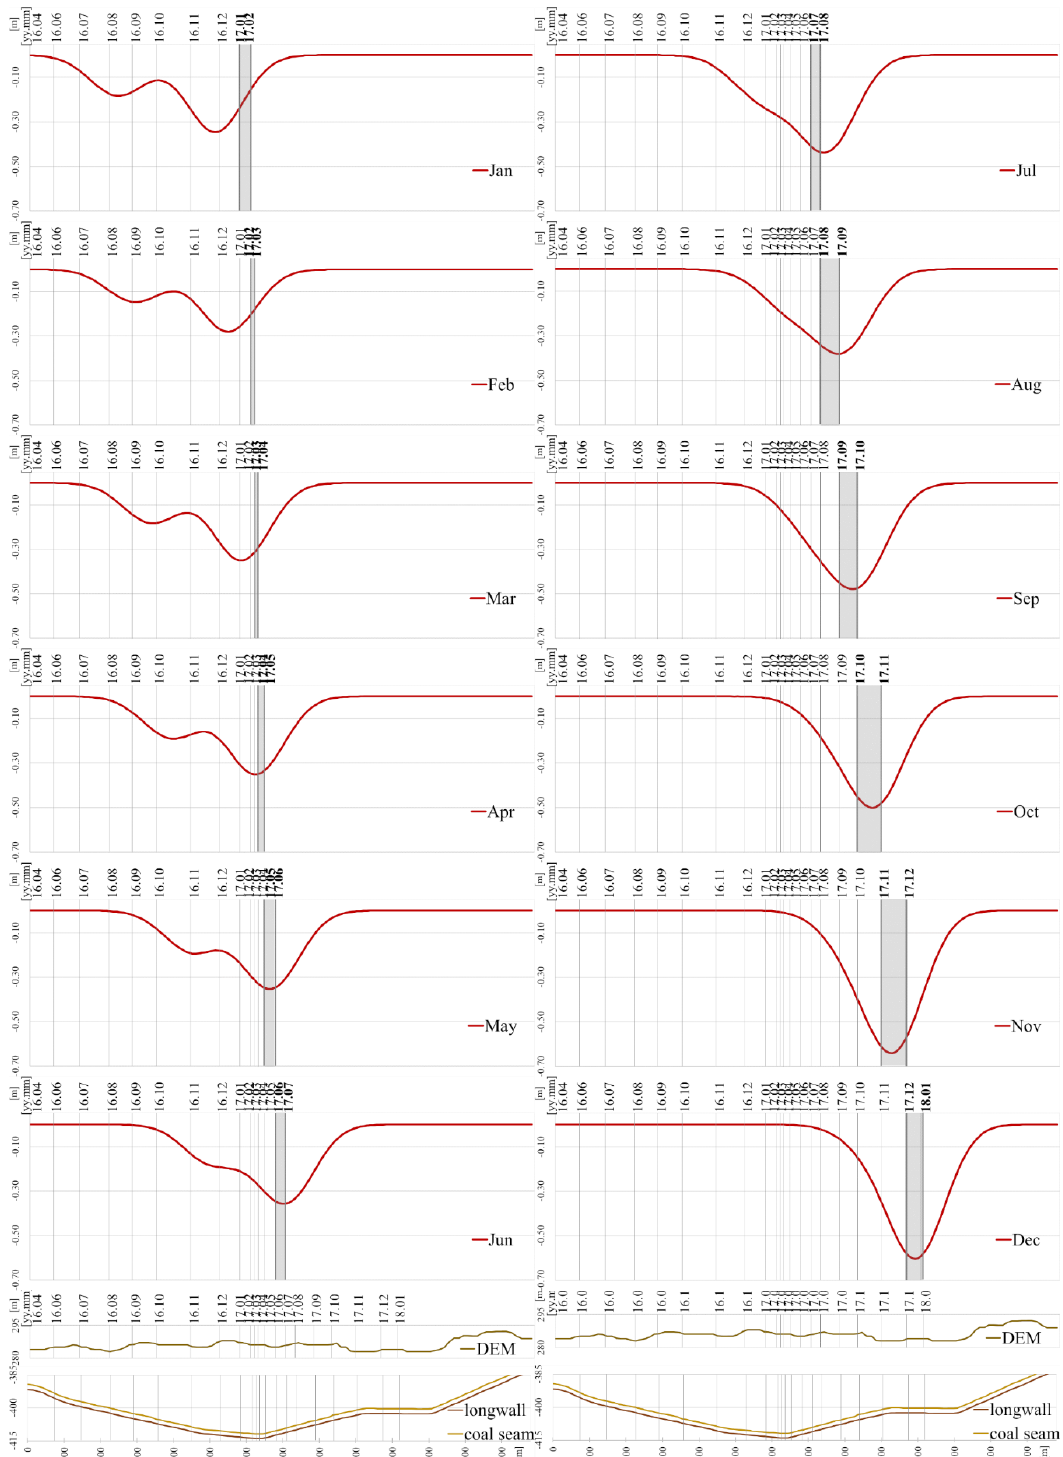
Figure 17. Profile B’B” (longwall No. 5) through the models. The red curves show the vertical subsidence by month in 2017. On the bottom of the figure, profiles of the DEM surface and depth and thickness of coal seam are presented.